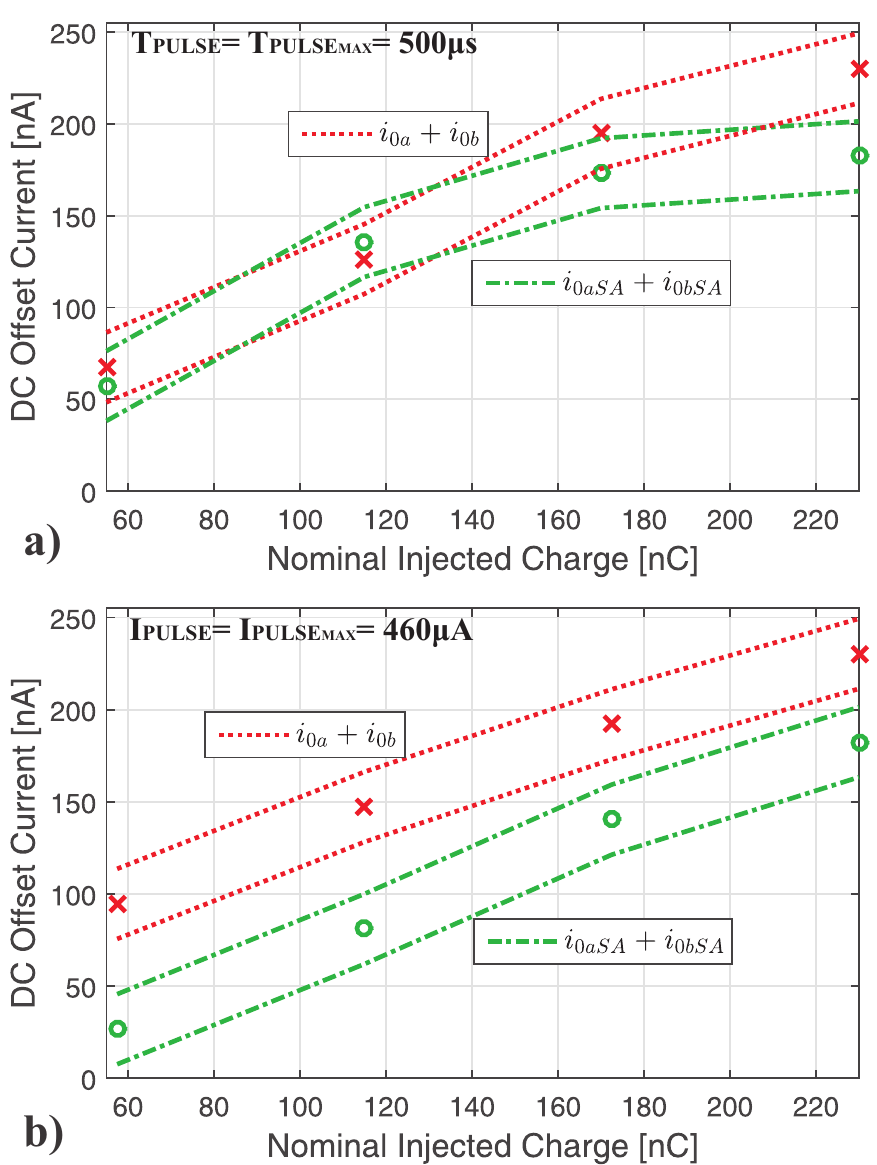
Figure 12. Hex Quasi-monopolar (HQ) stimulation pattern as in Figure 11a,b at 50 Hz. Comparison between the current source to the hexagonal site HEXa and HEXb excited simultaneously ( × : i 0 a + i 0 b in Figure 8) and the sum of the current source to a hexagonal site activated stand-alone (SA) ( ◦ : i 0 aSA + i 0 bSA in Figure 11). ( a ) Nominal injected charge Q PULSE versus DC offset current ( ± 3 σ range around the average value defined by dashed and dash-dotted lines) for a pulse width constant equal to = 500 µ s. ( b ) Nominal injected charge Q ± 3 σ range around T PULSE PULSE versus DC offset current ( MAX the average value defined by dashed and dash-dotted lines) for a stimulation current constant equal to = 460 µ I PULSE = I PULSE MAX